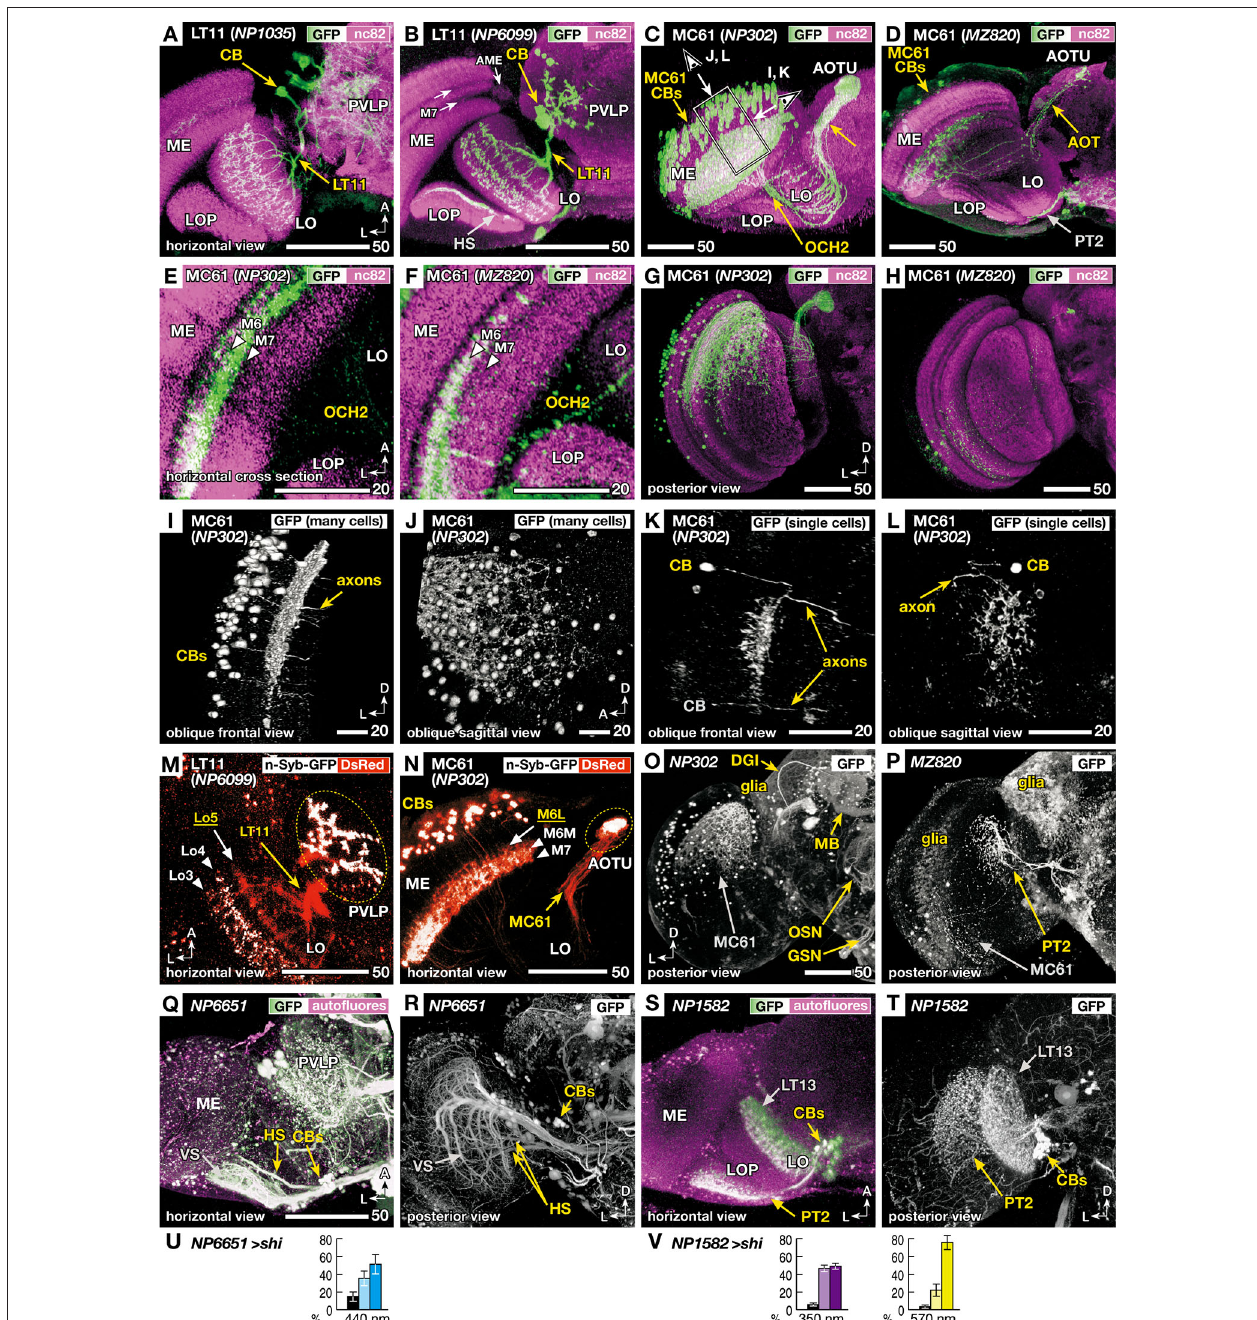
indicate the region and the direction of oblique frontal views shown in Figures 3I, L . ME: medulla, AME: accessory medulla, LO: lobula, LOP: lobula plate, PVLP: posterior ventrolateral protocerebrum, AOT: anterior optic tract, AOTU: anterior optic tubercle, OCH2: second optic chiasmus. (E, F) High-magnification view of the horizontal sections of NP302 and MZ820 strains, showing specific arborizations in the medulla M6 and M7 layers (triangles). Note that the dendrites in the 3D reconstruction images of Figures 3C, D, G, H appear to extend more medially, because they visualize all the arborizations along the curved surface of the M6 and M7 layers. (G, H) Posterior 3D reconstruction of these strains, showing the labeling in different subsets of the MC61 neurons in the dorsal and ventral halves of the medulla. ( Continued